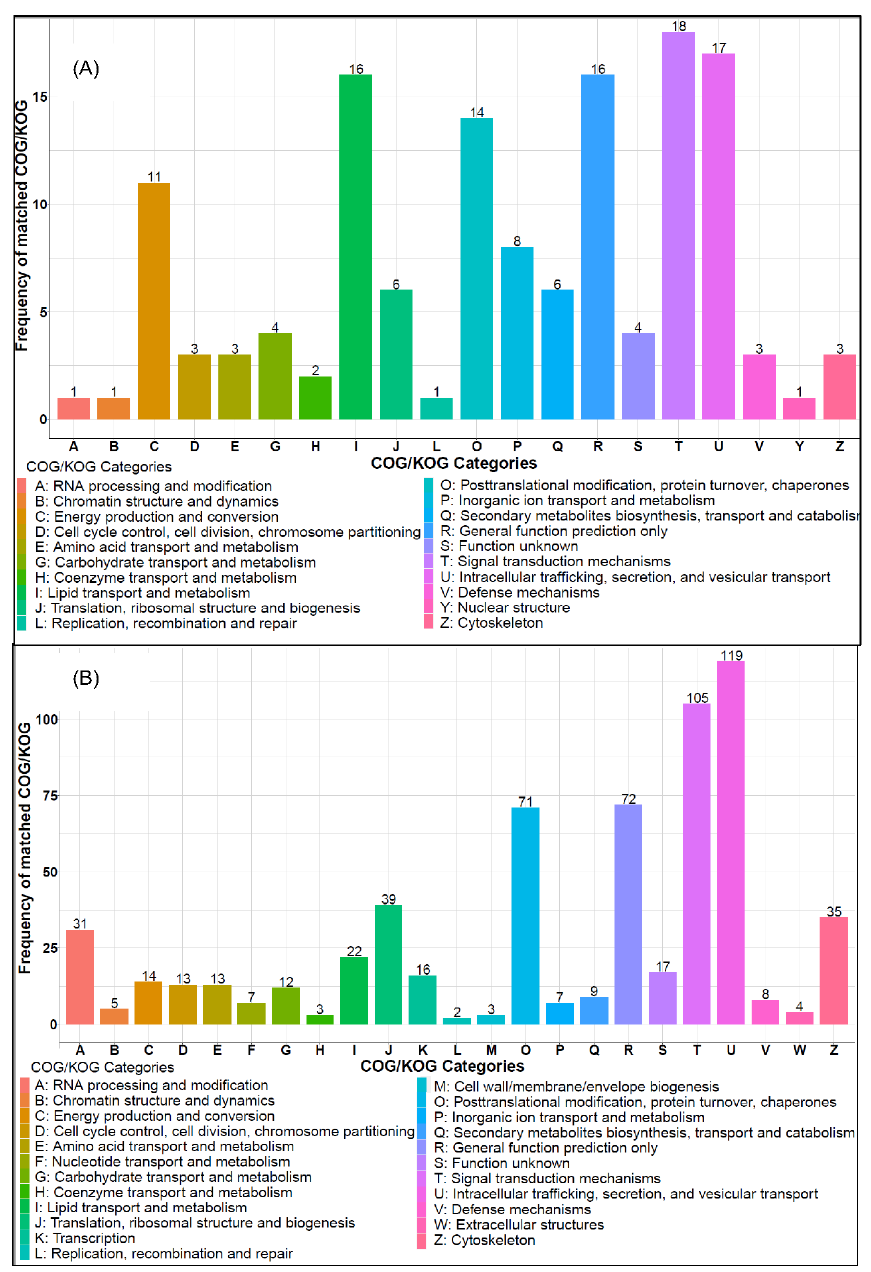
Figure 4. The COG/KOG analysis of DEPs in control ( A ) and HFD-T ( B ) group as compared to HFD